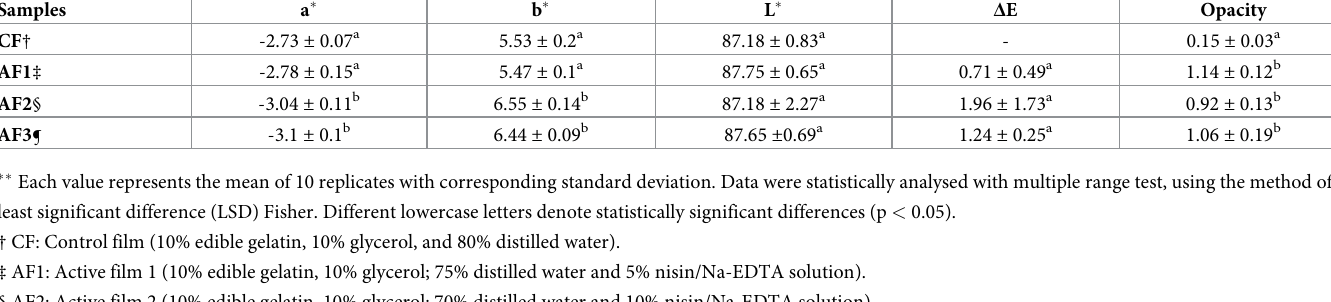
Table 2. Analysis of color and opacity of elaborated films. �� Samples